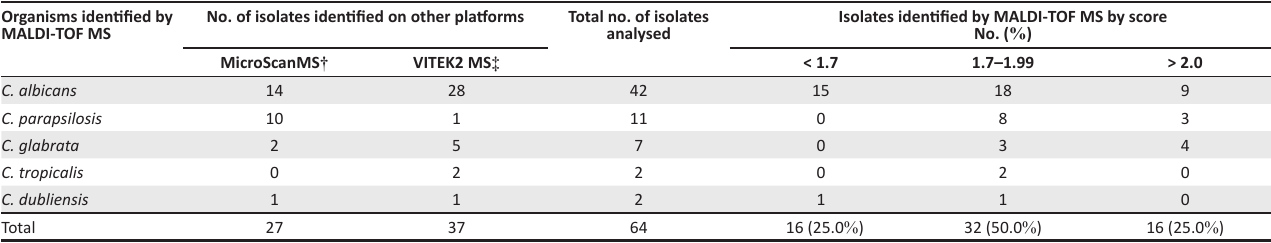
TABLE 3: Yeast isolates identified by MALDI-TOF MS ( N = 64), Bloemfontein, South Africa, 15 July 2013 to 30 September 2013. Organisms identified by MALDI-TOF MS